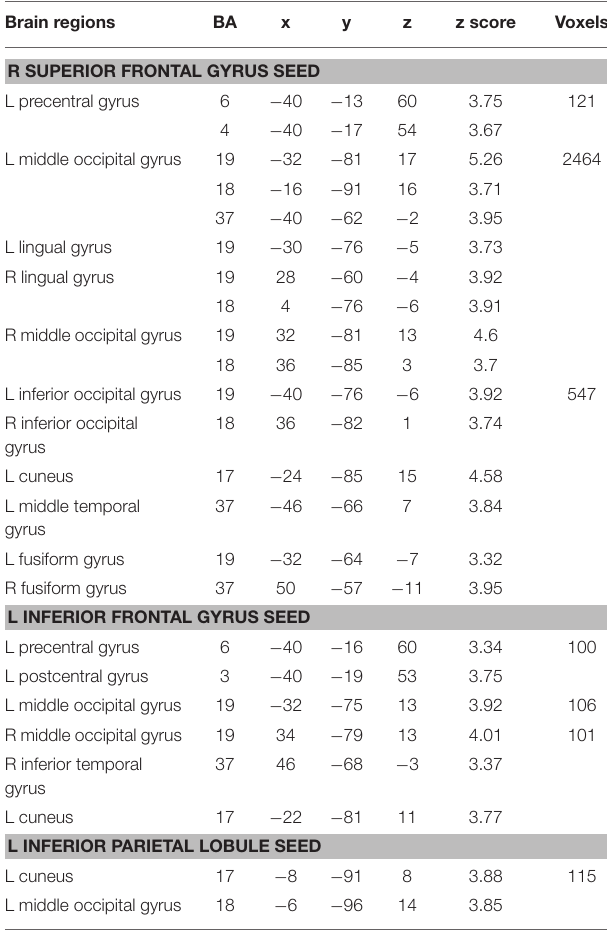
TABLE 2 | Functional connectivity associated with the word-frequency effect (LFC > HFC) during Chinese writing. Brain